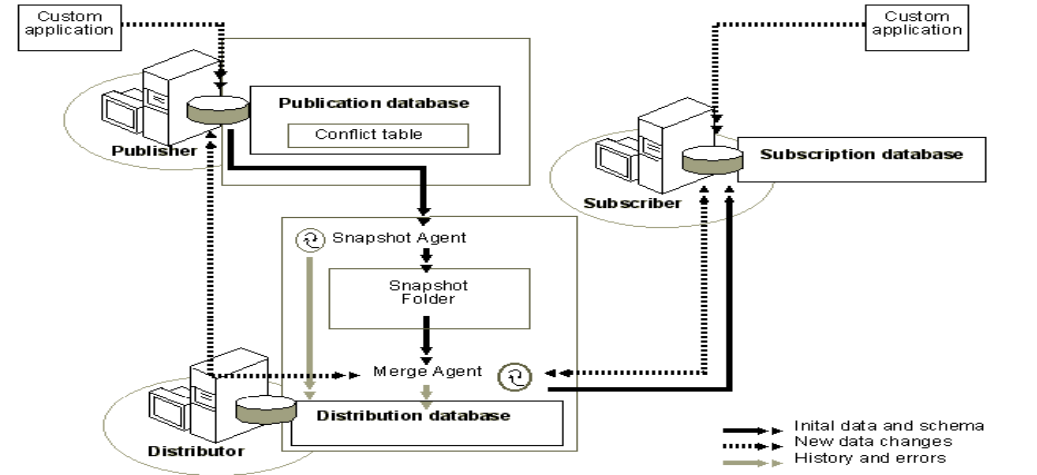
Figure 4: Merge Replication Process (MSDN,